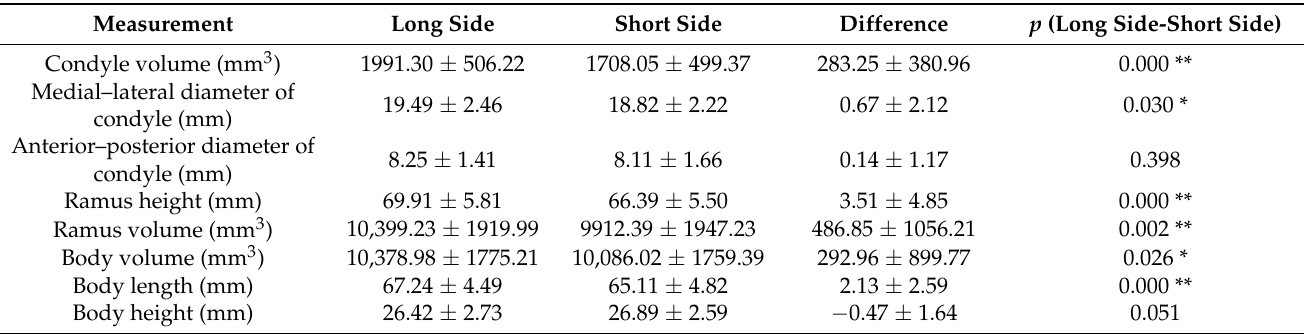
Table 2. Comparison of the mandibular morphology on both sides before surgery (T0) in patients with asymmetric mandibular prognathism.